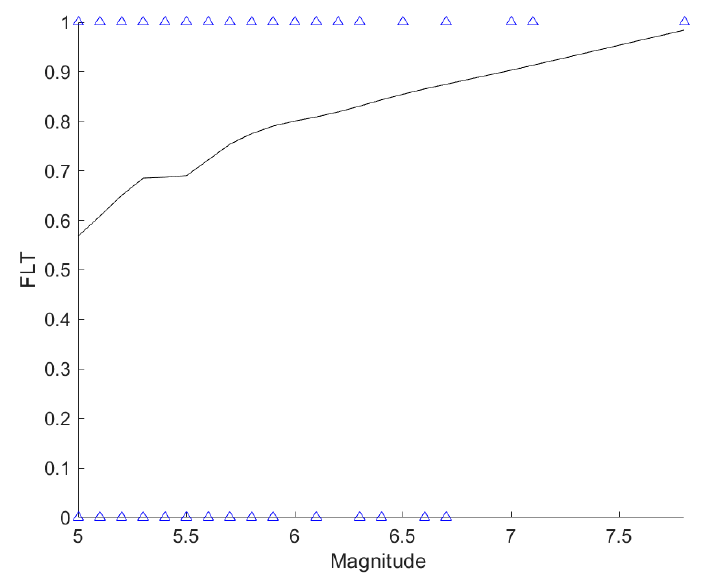
Figure 11. Fault covariate values for targeted earthquakes against magnitude, 1951–2020. The solid black line shows the smoothed scatter plot. The blue triangles depict the values of the FLT covariate for each target earthquake.